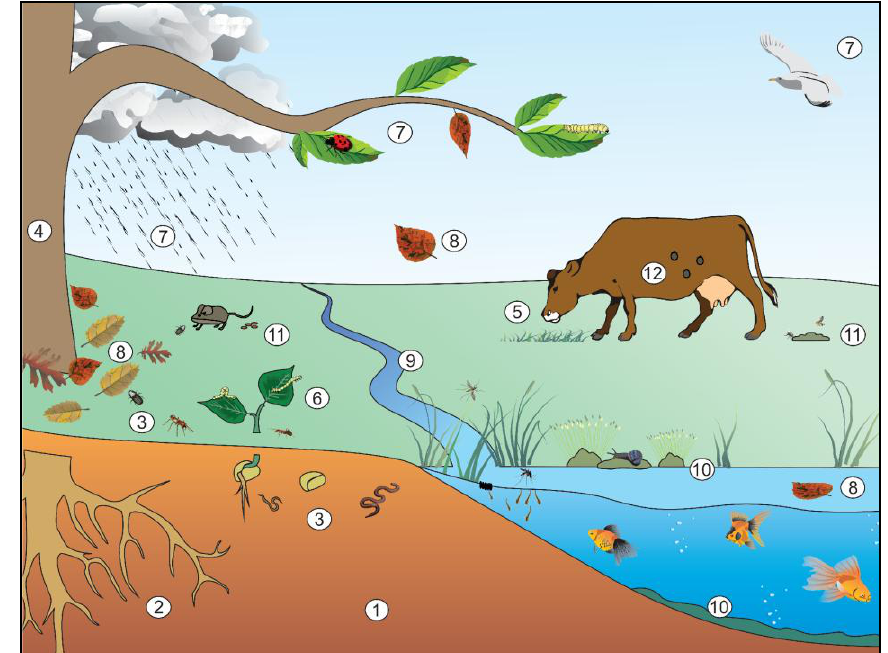
Figure 1. Simplified view of complex lifestyle of Bacillus thuringiensis ( Bt ) in different environmental niches. Vertebrates and invertebrates are only examples of a much wider range of possible hosts. The soil ( 1 ) is usually the largest reservoir of Bt , because it receives the highest amount of propagules from other environments. From it, Bt can colonize the rhizosphere ( 2 ) feeding on roots exudates. If eaten by soil invertebrates such as worms, insects and nematodes ( 3 ), Bt can infect in a paratenic way, colonizing the gut and feces, or in a pathogenic way, killing the host and growing in the cadaver. Thus Bt is re-introduced into the environment through these two ways. Rhizosphere colonization favors endophytic colonization ( 4 ) which protects the plant from some herbivores, while helps Bt to proliferate in plant tissues and infecting herbivores in paratenic ( 5 ) or pathogenic ( 6 ) ways. Besides endophytism, Bt can reach the surface of the plants from the soil due to the germination process, by splashes of rain water, and through the feces of animals that carry it, such as insects and birds ( 7 ). The infected fallen leaves can re-introduce Bt in soil and water ( 8 ). The rain may also carry the Bt to water bodies from soil and plants ( 9 ). In water the Bt can infect and proliferate in vertebrates or invertebrates and persiste in this environment by associating with substrates as aquatic plants and sediments ( 10 ). Faeces from animals that feed on contaminated plants or insects can serve as a source of nutrients for Bt growth, and they can act as a source of infection for coprophagous ( 11 ). It is known that ticks and mites are also Bt hosts ( 12 ), but the natural mechanism of infection is unknown. It is possible to observe a wide range of strategies for Bt occupy different niches and disperse in environment with or without causing